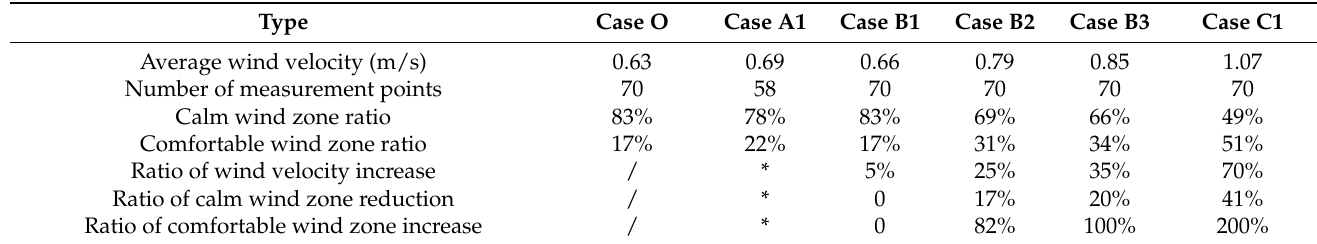
Table 2. Results of the wind environment simulation for the six cases.